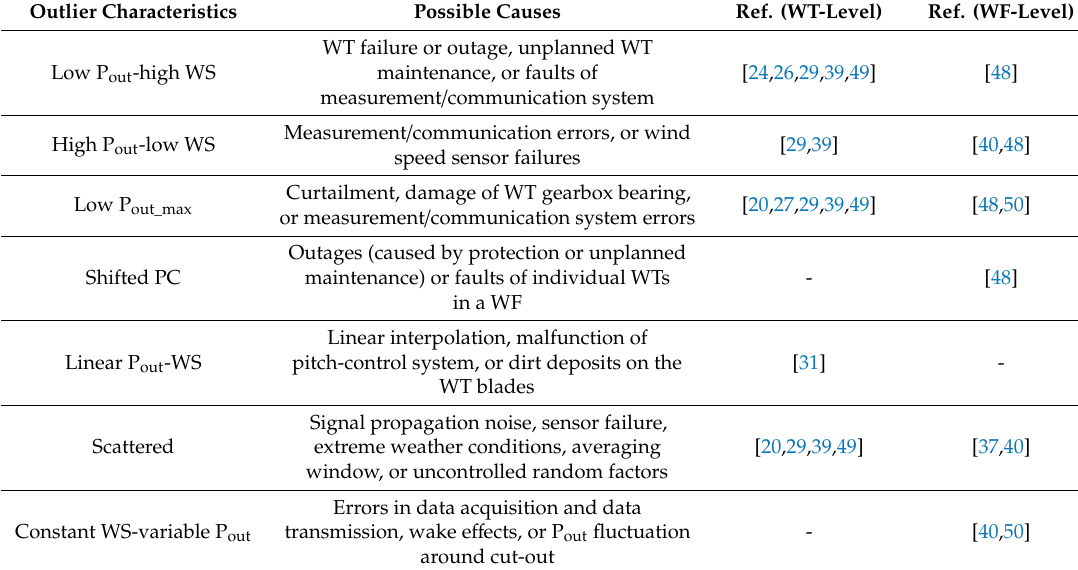
Table 3. Summary of characteristics and causes of outliers in WT and WF measurements. Outlier